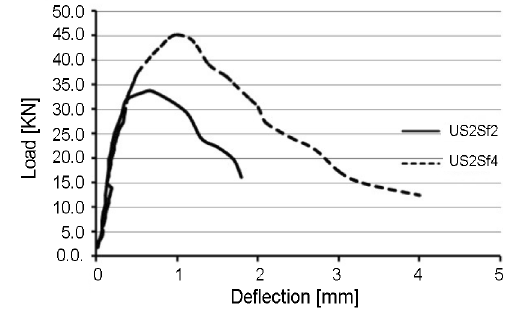
Fig. 7 . The load – midspan deflection relationship in bending test